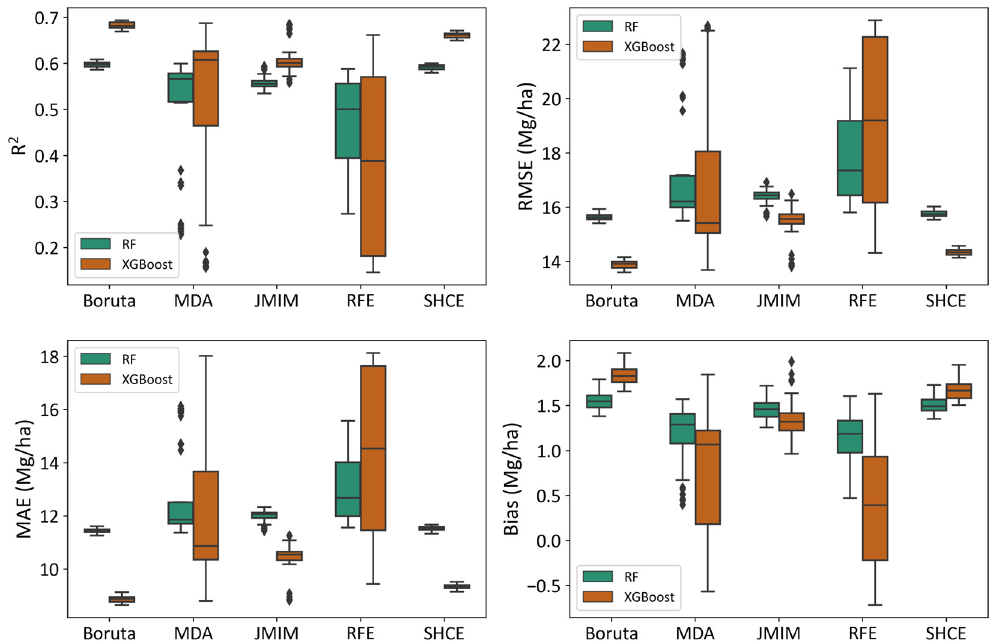
Figure 6. Boxplots showing forest AGB prediction accuracy using features selected by each FS algorithm for both RF and XGBoost models.